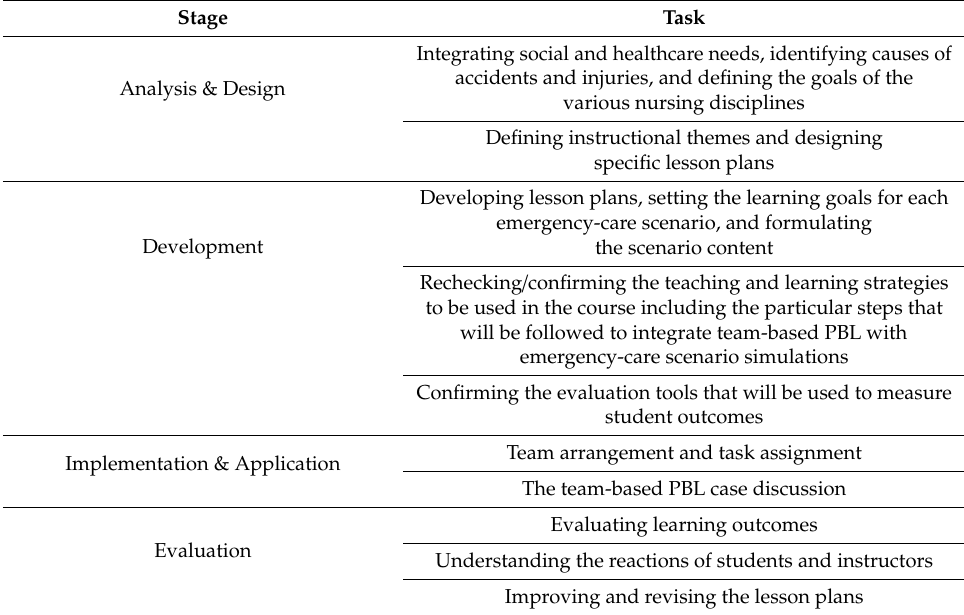
Table 1. Framework for the integrative curriculum (team-based PBL combined with emergency-care scenario